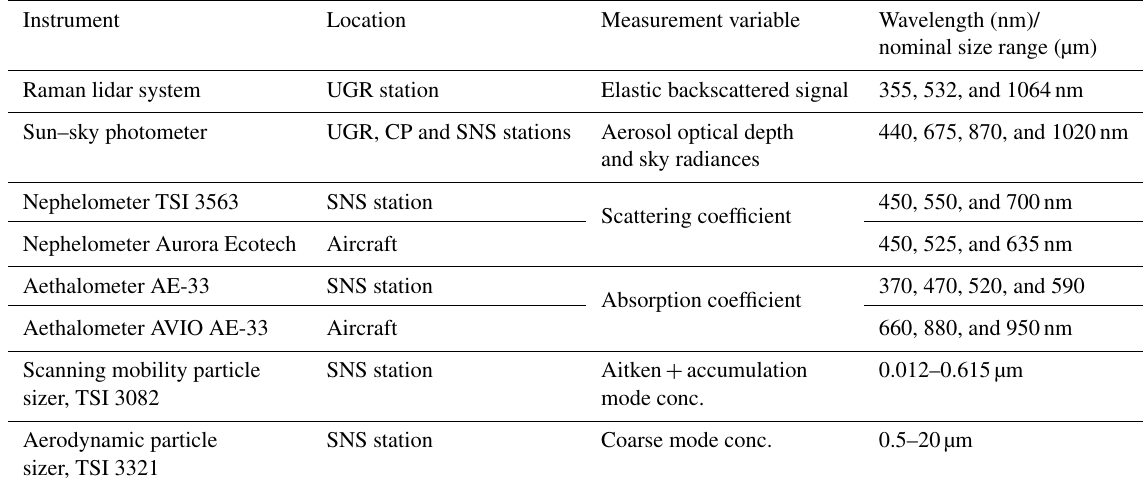
Table 1. Instruments deployed during the SLOPE I and II campaigns at the AGORA